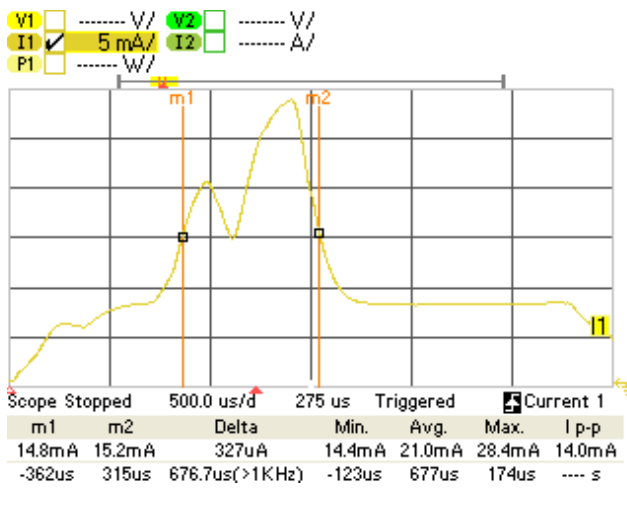
Figure 7. Latency measurement of a one-way ATT exchange, performed on the basis of a CC2540 slave current consumption plot. The marker m1 is placed at the start of the reception of the poll packet from the master. The marker m2 is placed at the end of the notification